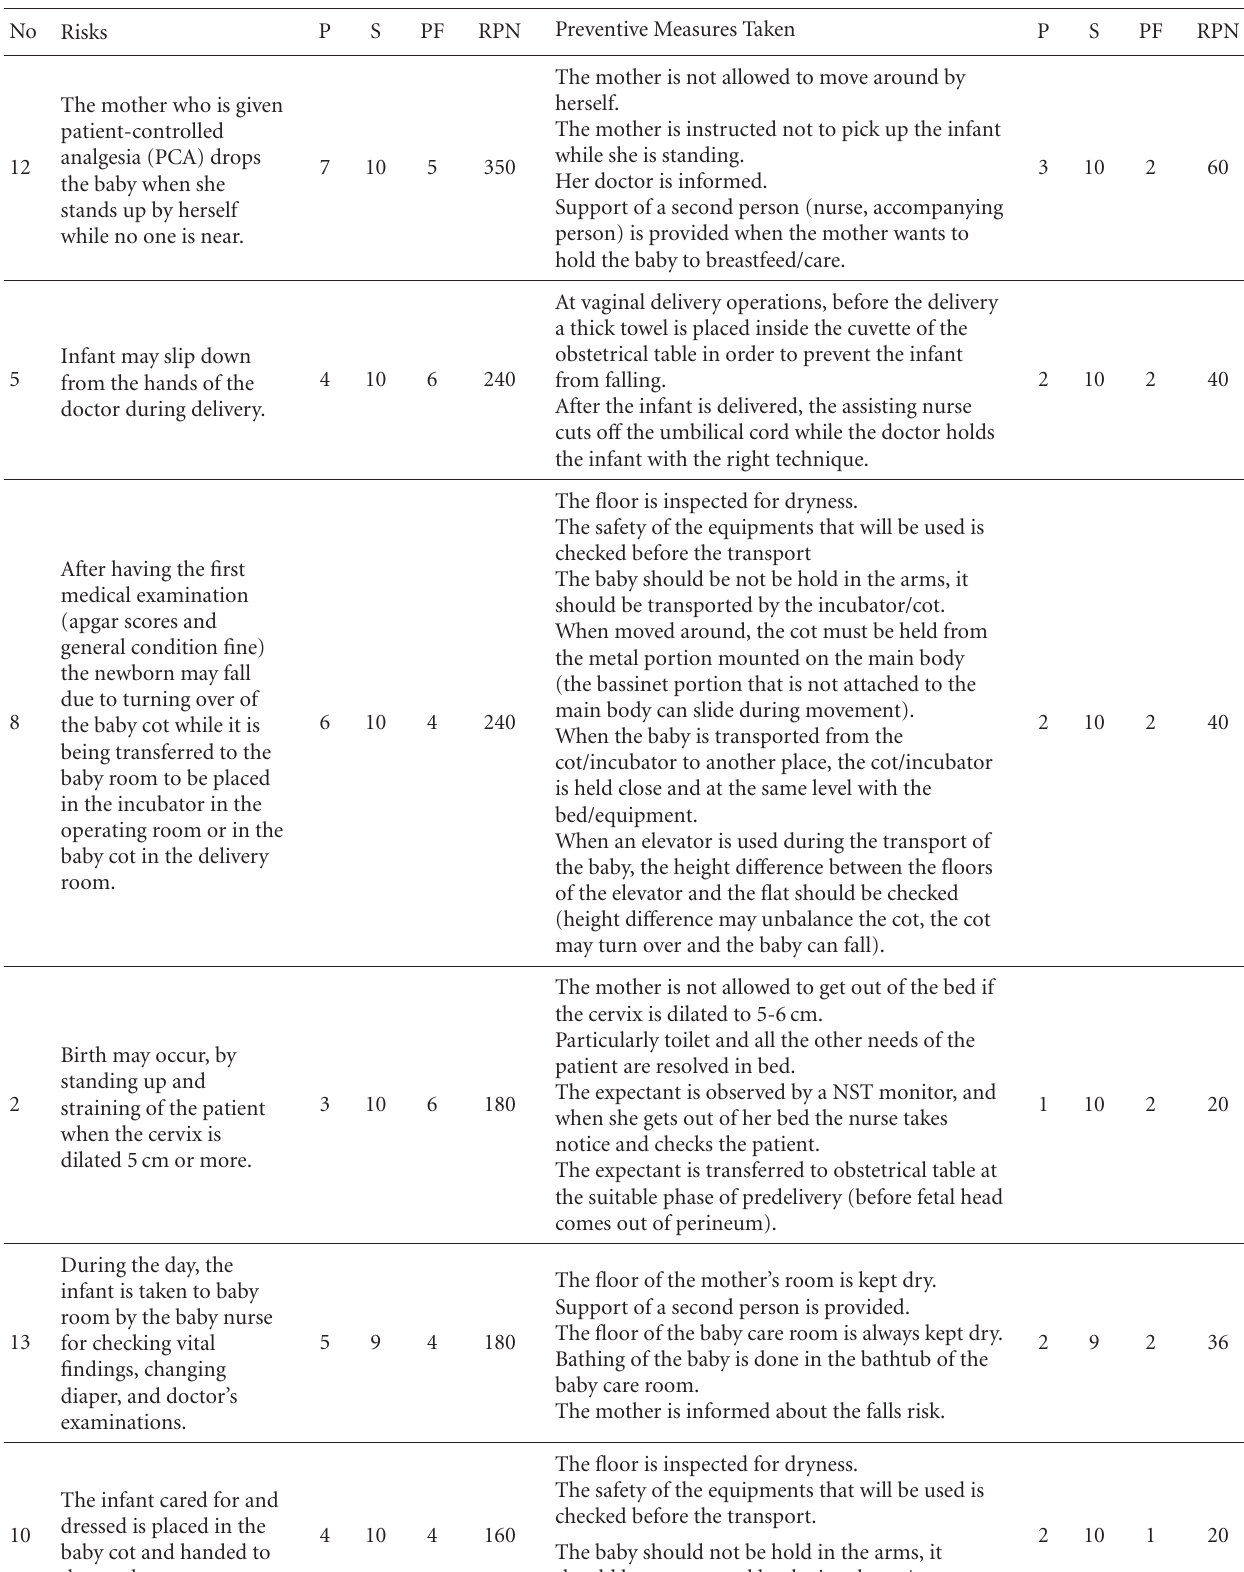
Table 2: Risk priority numbers determined before and after the preventive